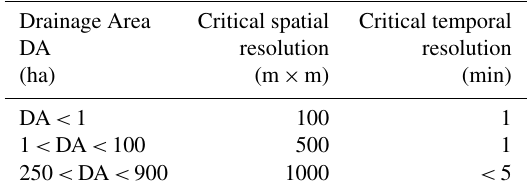
Table 4. Critical resolutions in relation with the drainage